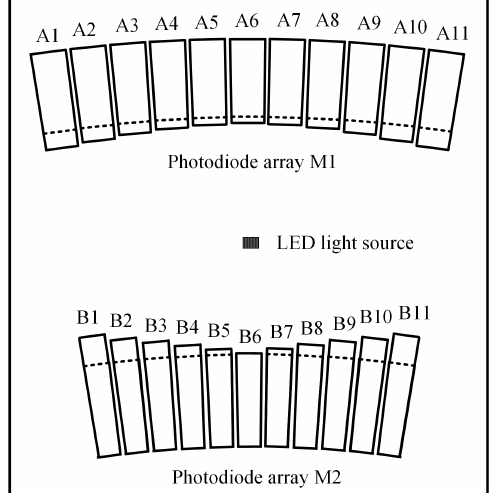
Figure 5. Photodiode arrays corresponding to M-code